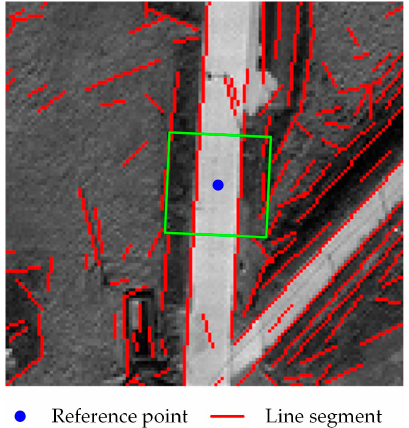
Figure 5. Establishment of the rectangular search area.